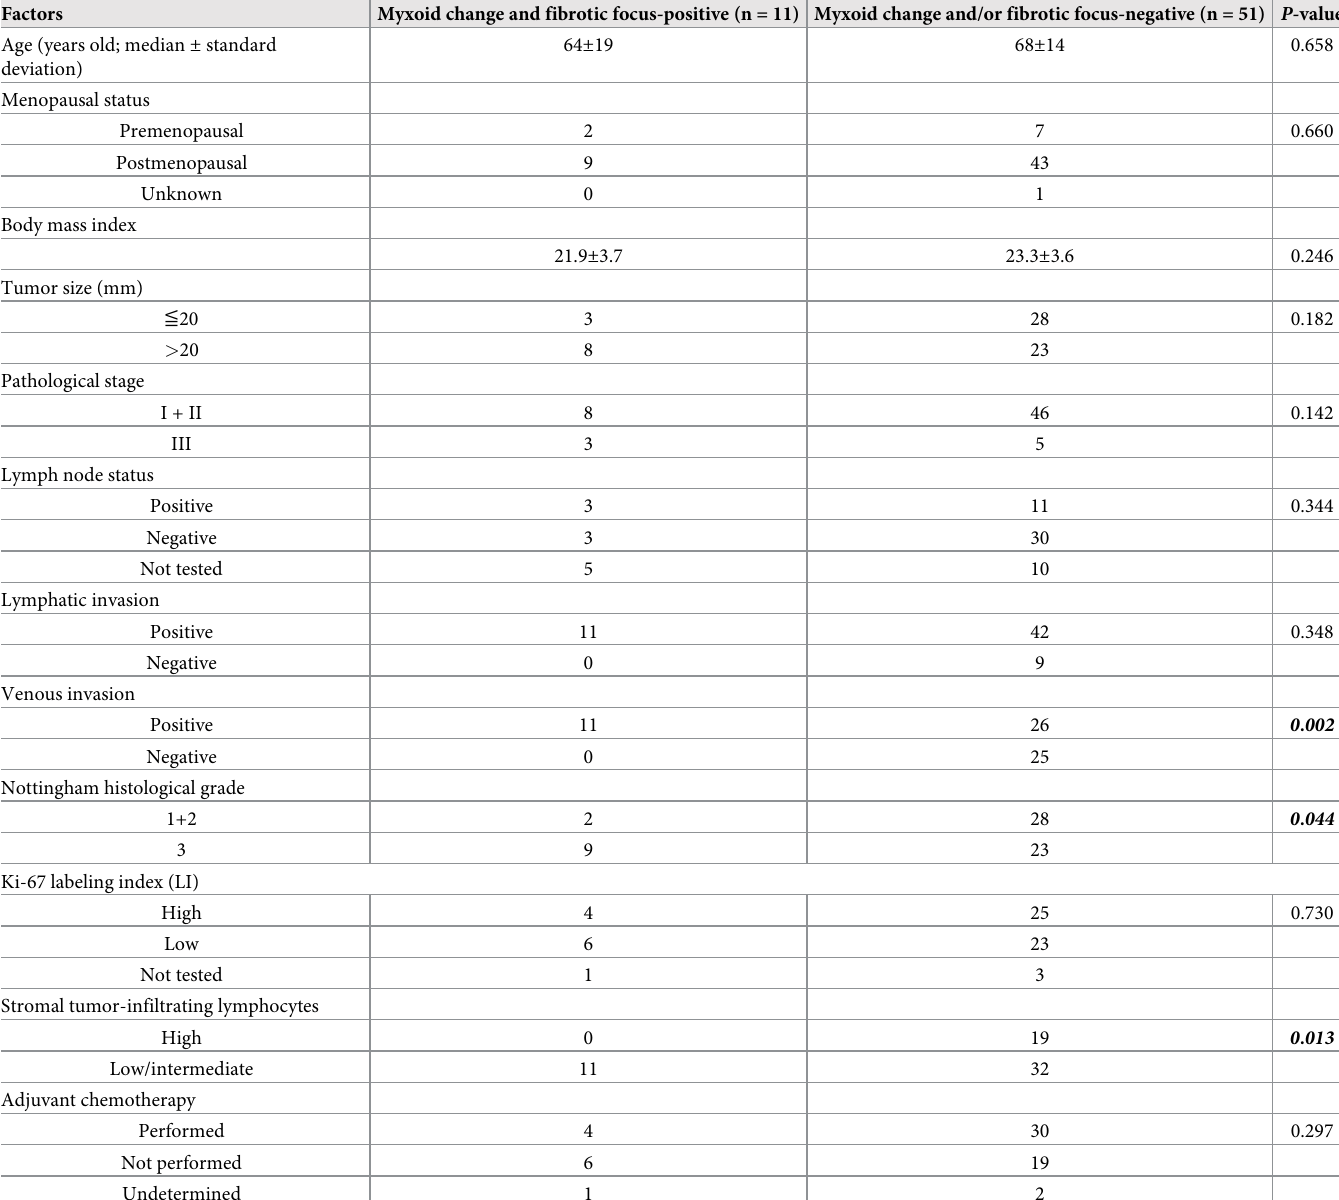
Table 4. Association of myxoid change and fibrotic focus with clinicopathological factors. Factors Myxoid change and fibrotic focus-positive (n = 11) Myxoid change and/or fibrotic focus-negative (n = 51) P